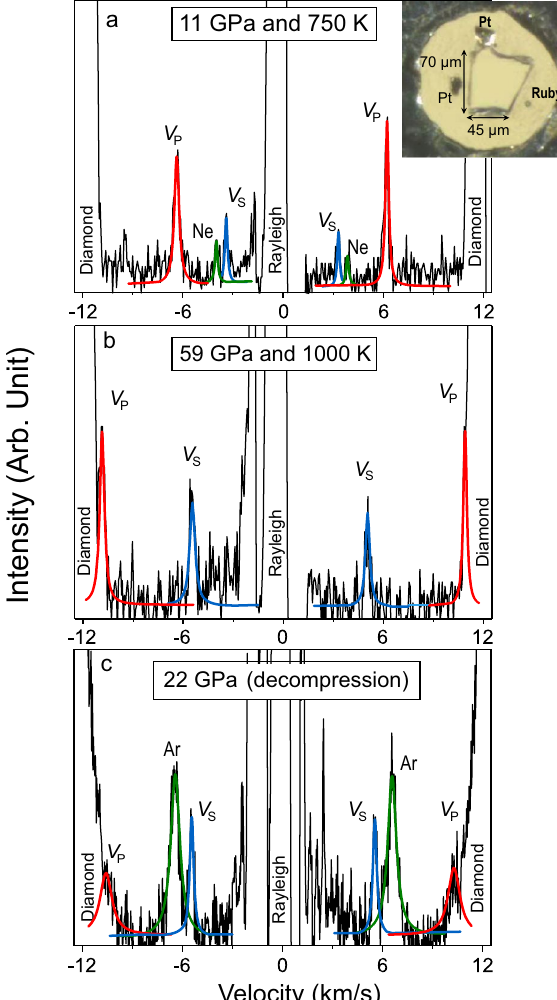
Figure 1. Representative Brillouin spectra of SiO 2 glass at high pressures and temperatures. ( a ) At 11 GPa and 750 K; ( b ) at 59 GPa and 1000 K; ( c ) quenched and decompression to 22 GPa and 300 K. Black lines: raw data; red lines: fitting results for the longitudinal modes, V P ; blue lines: fitting results for the transverse modes, V S . Insert figure is a representative sample photo taken at 7